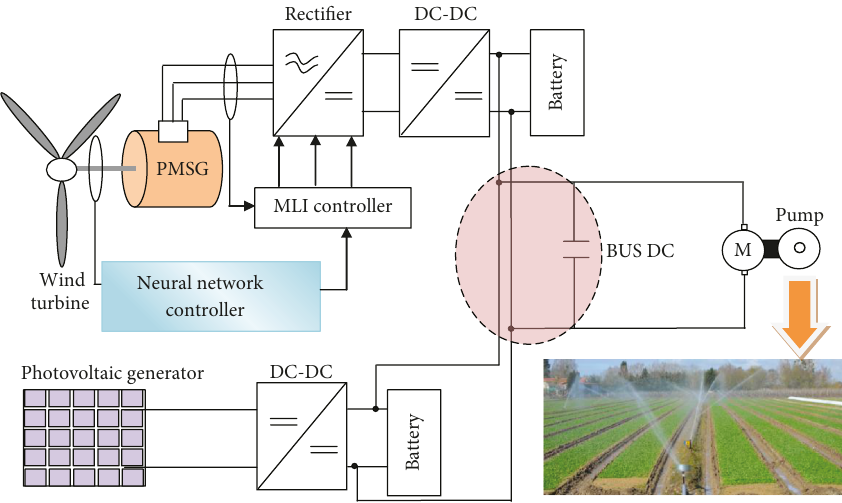
Figure 1: Global scheme of a hybrid pumping system.